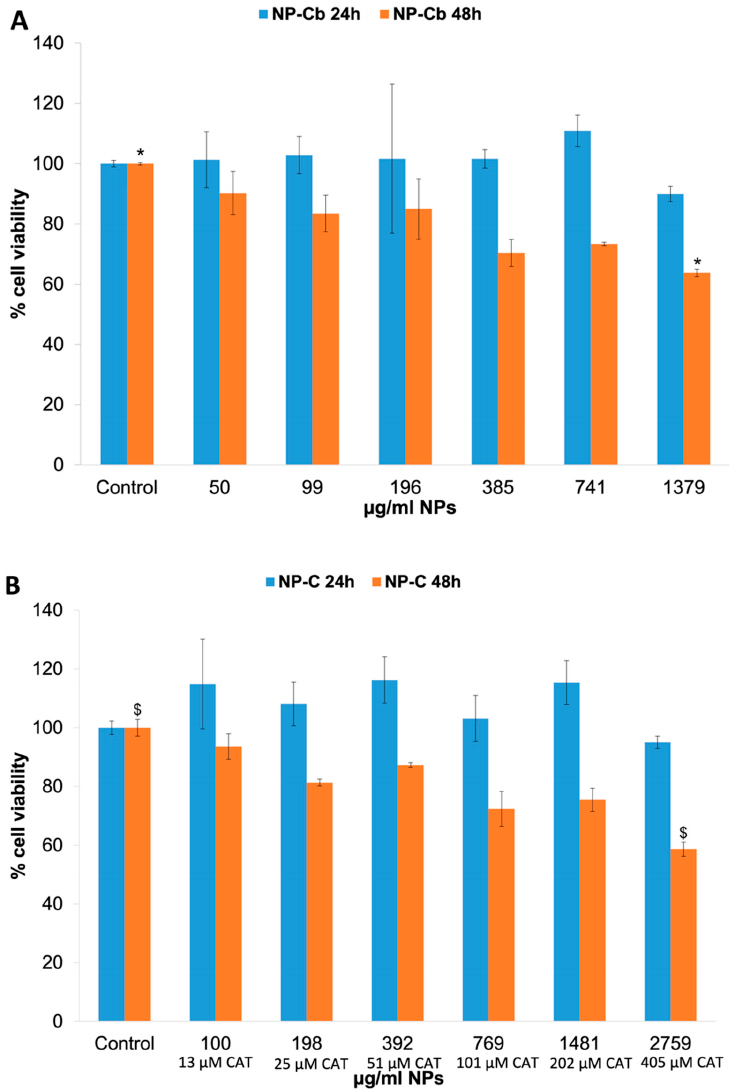
Figure 8. In vitro cytotoxicity. ( A ) Effect of NP ‐ Cb on HFF ‐ 1 cells after 24 h (blue bars) and 48 h (orange bars) of incubation: * p value < 0.05: the effect of 1.379 μ g/mL NP ‐ Cb vs. control. ( B ) Effect of NP ‐ C on HFF ‐ 1 cells after 24 (blue bars) and 48 h (orange bars) of incubation: $ p value < 0.05: the effect of 2.759 μ g/mL NP ‐ C vs. control.